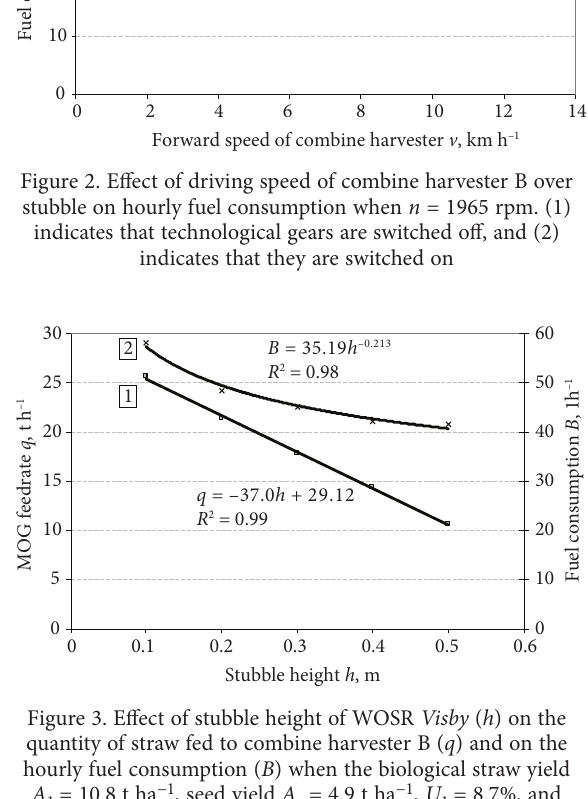
Table 5. Hourly fuel consumption of combine harvester engines without technological threshing process